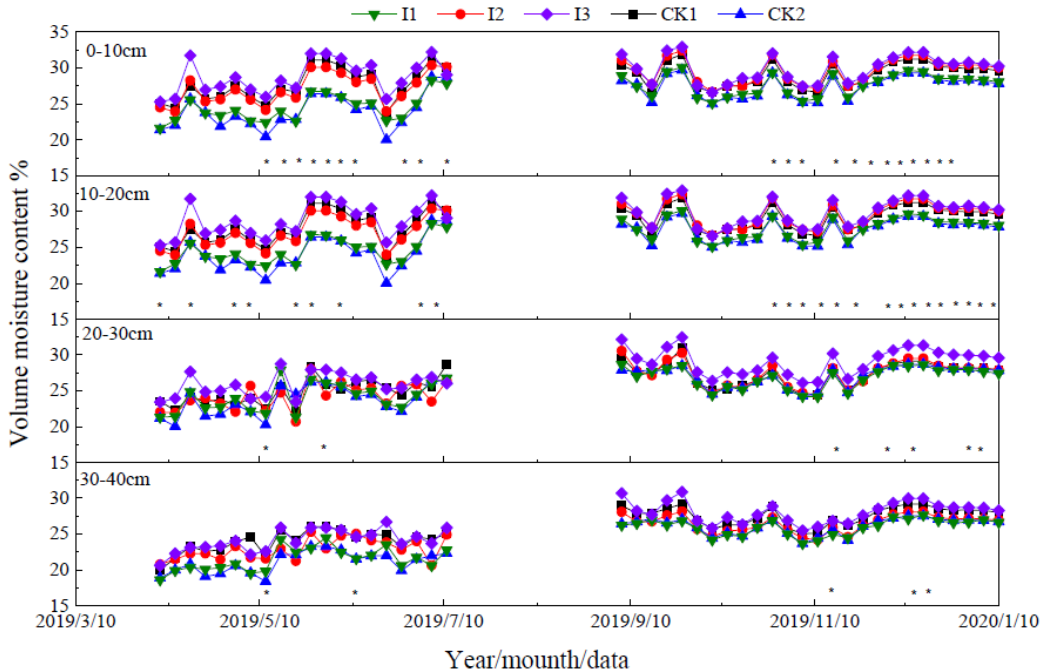
Figure 4. Changes of soil moisture with tomato growth period under different treatments. Note: the 0–10, 10–20, 20–30, and 30–40 means soil at a depth of 0–10, 10–20, 20–30, and 30–40 from the surface; the vertical coordinate represents soil volume moisture content, %; the horizontal axis represents the date; and the figure * indicates that there is a significant positive correlation between volumetric soil water content and yield at this stage.